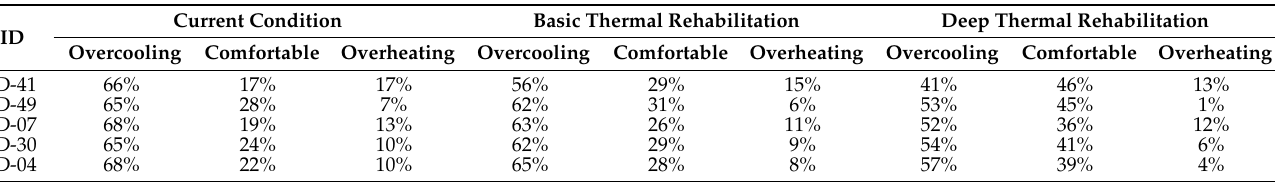
Table 11. Thermal comfort of occupants based on operative temperature in one